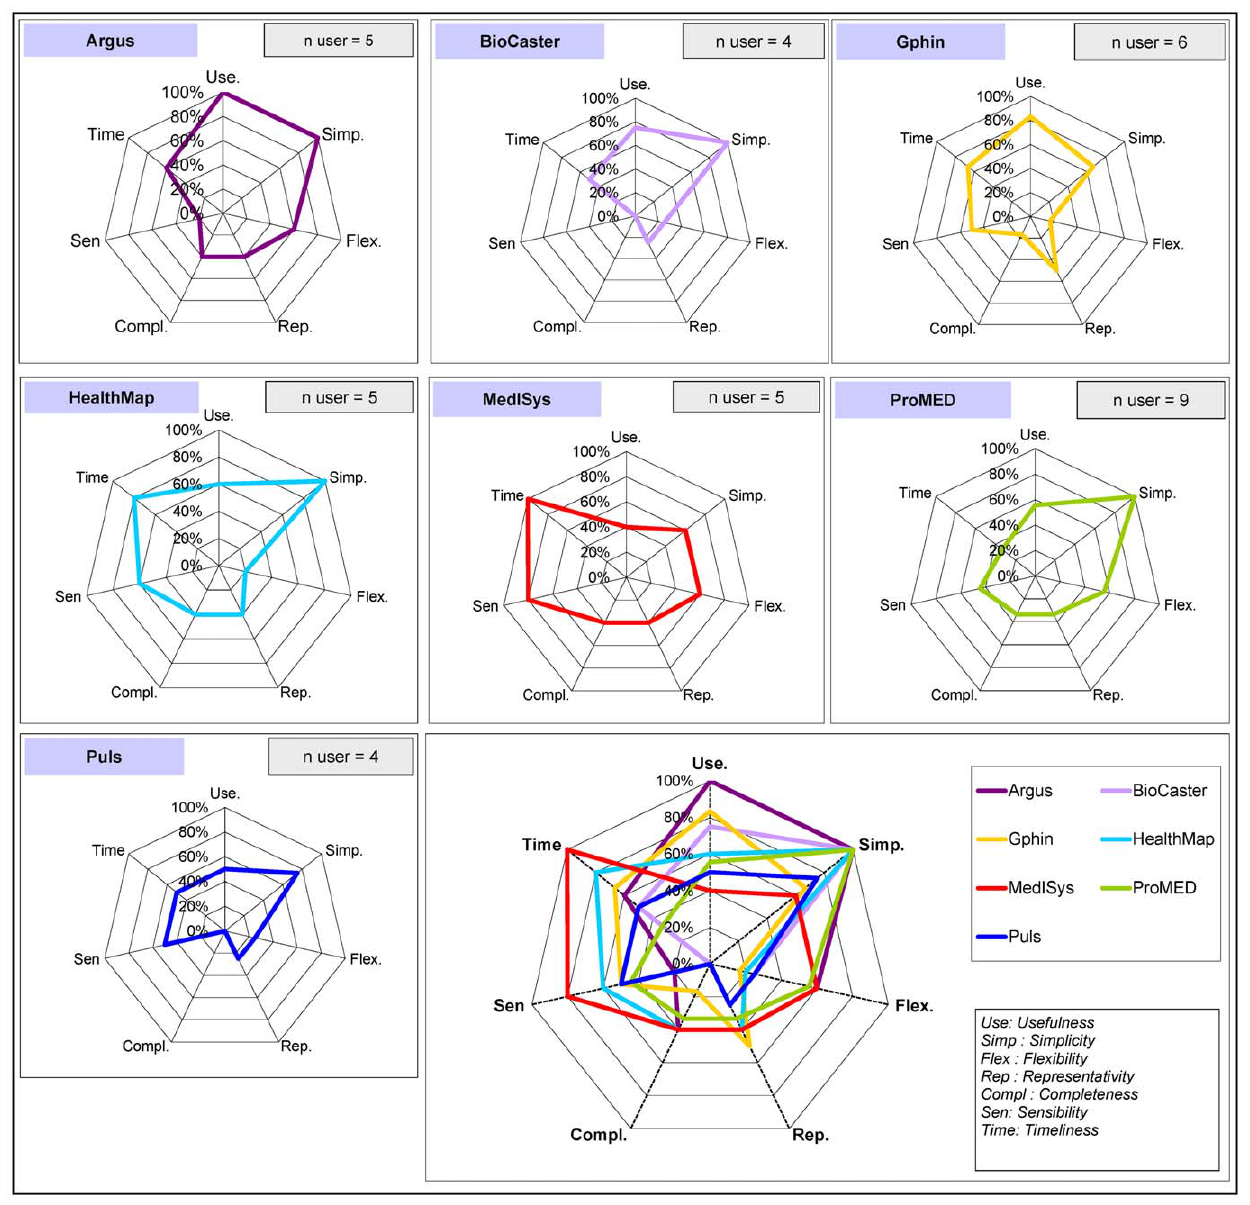
Figure 1. Users’ perception regarding systems performances.